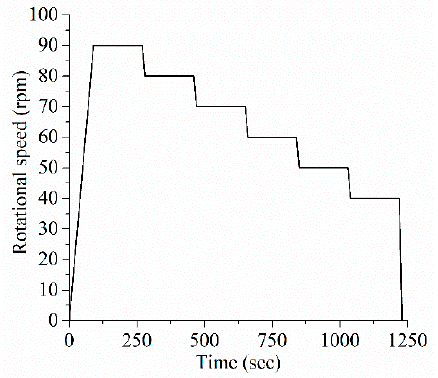
Figure 3. Rheological protocol.